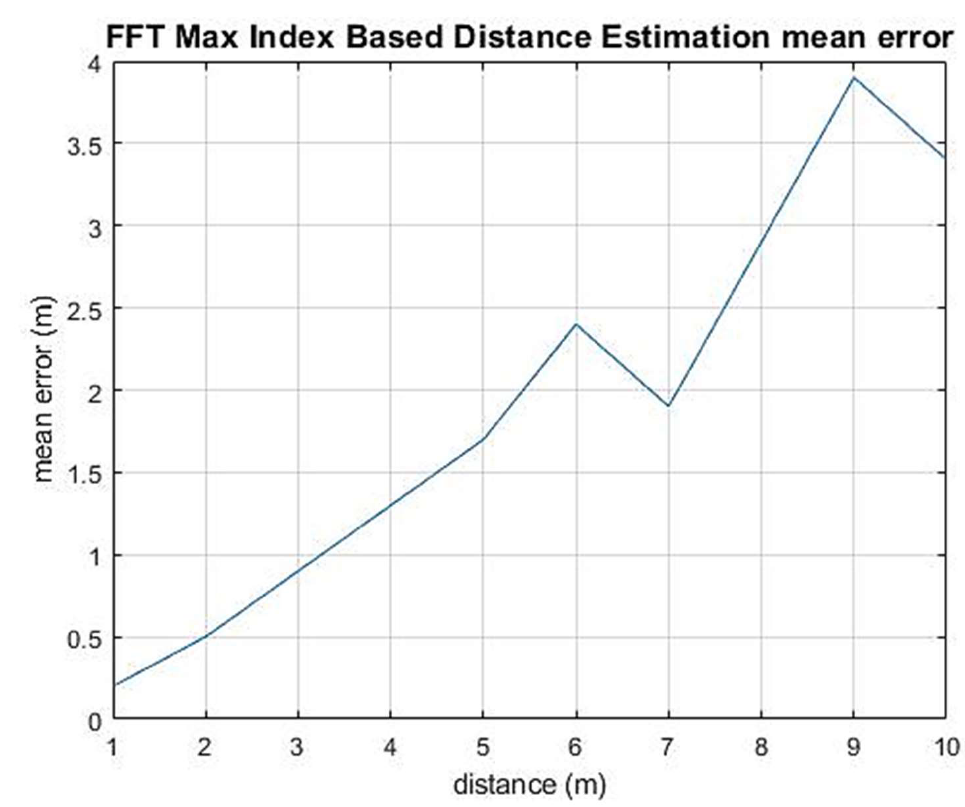
Figure 5. Estimated distance mean error graph of conventional scheme.